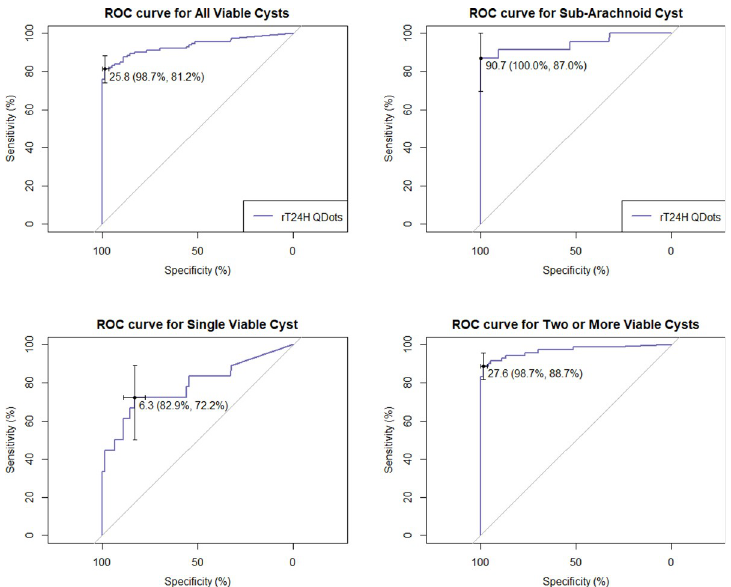
Fig 2. ROC curves for detection of total IgG responses in serum from patients with neurocysticercosis, using rT24H QDots based assay. Curves were developed using pROC package in R software version 3.3.3. 25.8 (98.7%, 81.2%) means at the cut-off point 25.8, the sensitivity is 81% and the specificity is 98.7%.